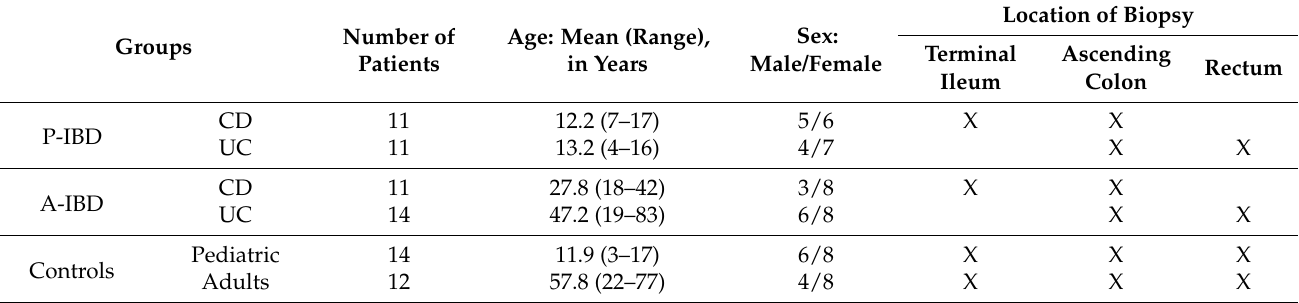
Table 1. Total number of patients used for this study per group and their characteristics. P-IBD: children and adolescents with inflammatory bowel disease (IBD); A-IBD: adults with IBD; pediatric controls and adult controls. CD: Crohn’s disease; UC: ulcerative